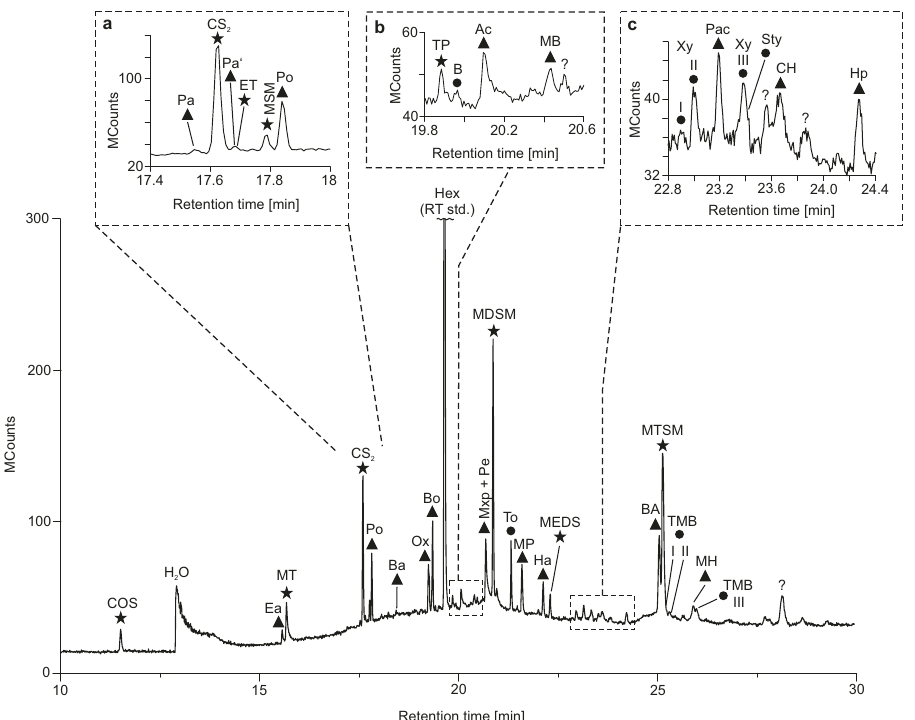
Fig. 5 Total ion current chromatogram of volatile compounds from black barite fl uid inclusions as obtained by solid phase micro extraction GC – MS (SPME-GC – MS). Inserts a – c represent enlargements of respective areas in the chromatogram marked by dashed lines. Triangles denote oxygen-bearing compounds, circles denote aromatic hydrocarbons and stars denote sulfur-bearing compounds. n -Hexane (Hex) was used as a retention time standard (RT std.). COS carbonyl sul fi de, Ea ethanal, MT methanethiol, Pa prop-2-enal, Pa ’ propanal, ET ethanethiol, MSM (methylsulfanyl)methane, Po propan-2-one, Ba but-2-enal, Ox oxolane, Bo butan-2-one, TP thiophene, B benzene, Ac acetic acid, MB 3-methylbutan-2-one, Mxp 1-methoxypropan-2-ol, Pe pentanal, MDSM (methyldisulfanyl)methane, To toluene, MP 4-methylpentan-2-one, Ha hexanal, MEDS (methyldisulfanyl)ethane, Xy I p -xylene, Xy II m -xylene, Pac 1-methoxyprop-2-yl acetate, Xy III o -xylene, Sty styrene, CH cyclohexanone, Hp heptanal, BA benzaldehyde, MTSM (methyltrisulfanyl)methane, TMB I 1,3,5-trimethyl benzene, TMB II 1,2,4-trimethyl benzene, MH 6-methylheptan-3-one, TMB III 1,2,3-trimethyl benzene. Note the higher diversity of compounds as compared to thermal decrepitation/desorption analysis (Fig. 4). Oxygen- and sulfur-bearing organic compounds may have provided substrates for microbial life in the Dresser Formation.